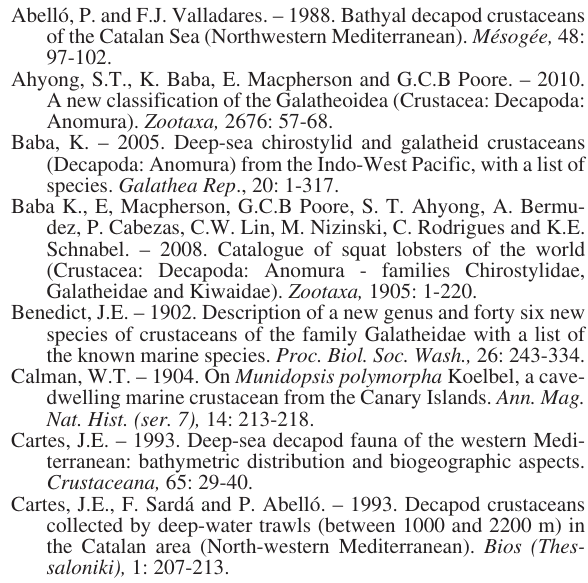
Figs. 10-14. Baba et al ., 2008: 168 (compilation). Material examined . NW Africa. Cape Barbas. 22º52’N, 19º43’W, 830-850 m, 12 July 1883: 1 male 6.1 mm, 3 ovigerous females 5.5- 7.8 mm, syntypes (MNHN-Ga293, 294, 295). NW Africa. Ras-al-Abiad Cape. FS Meteor. Cruise Auftrieb 75. Stn M36-103AT154. 21º24.6’N, 17º53.6’W, 27 February 1975, 1023- 1040 m: 2 males 5.3-5.6 mm, 4 ovigerous females 5.8-7.2 mm, 1 female 7.0 mm